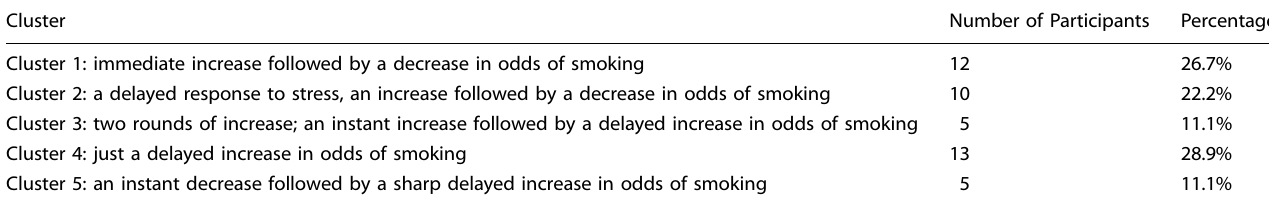
Table 2. Number of participants and the percentage for each detected